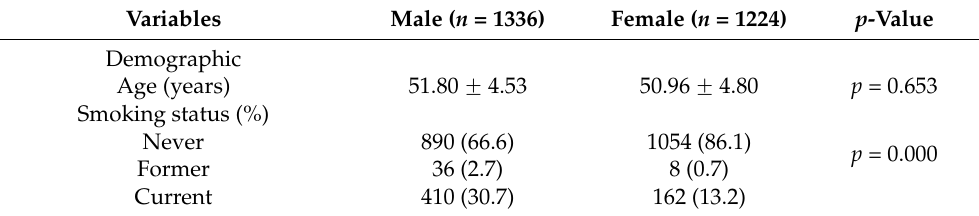
Table 1. Demographic and lifestyle characteristics of participants by gender in